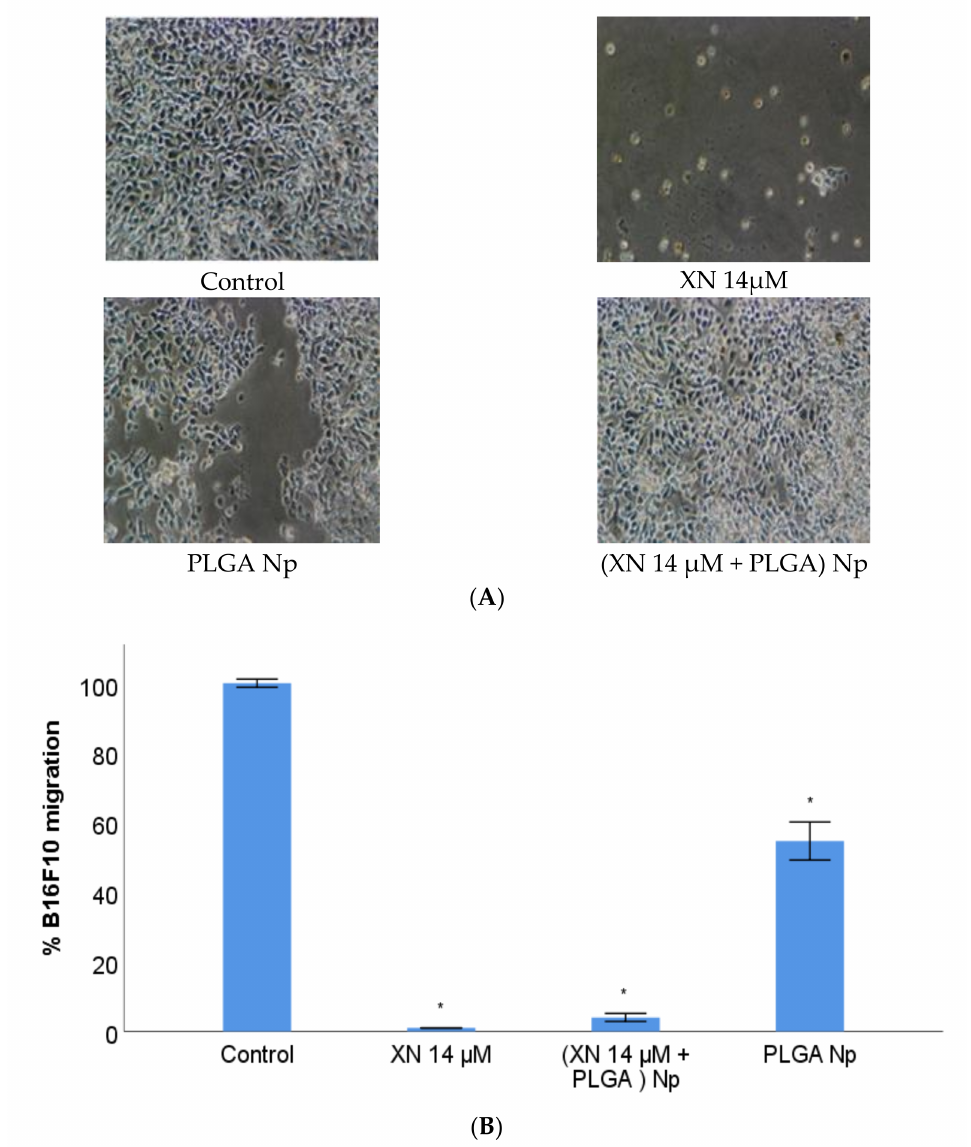
Figure 5. B16F10 Wound Healing assay with XN-loaded PLGA nanoparticles compared to XN solubilized form after 24 h treatment. The control refers to injury assay of B16F10 cells incubated with DMEM. “XN”, “Np”, and “PLGA” stands for XN, nanoparticles and poly-lactic-co-glycolic acid, respectively. ( A ) Representative inverted optical microscopic images, 200 × . ( B ) Bars represent B16F10 cells migration towards the injured space. B16F10 migration is expressed in mean percentage ± S.E.M. ( n = 3 for each treatment assay). * Statistically different at a level of p < 0.050 in comparison with the